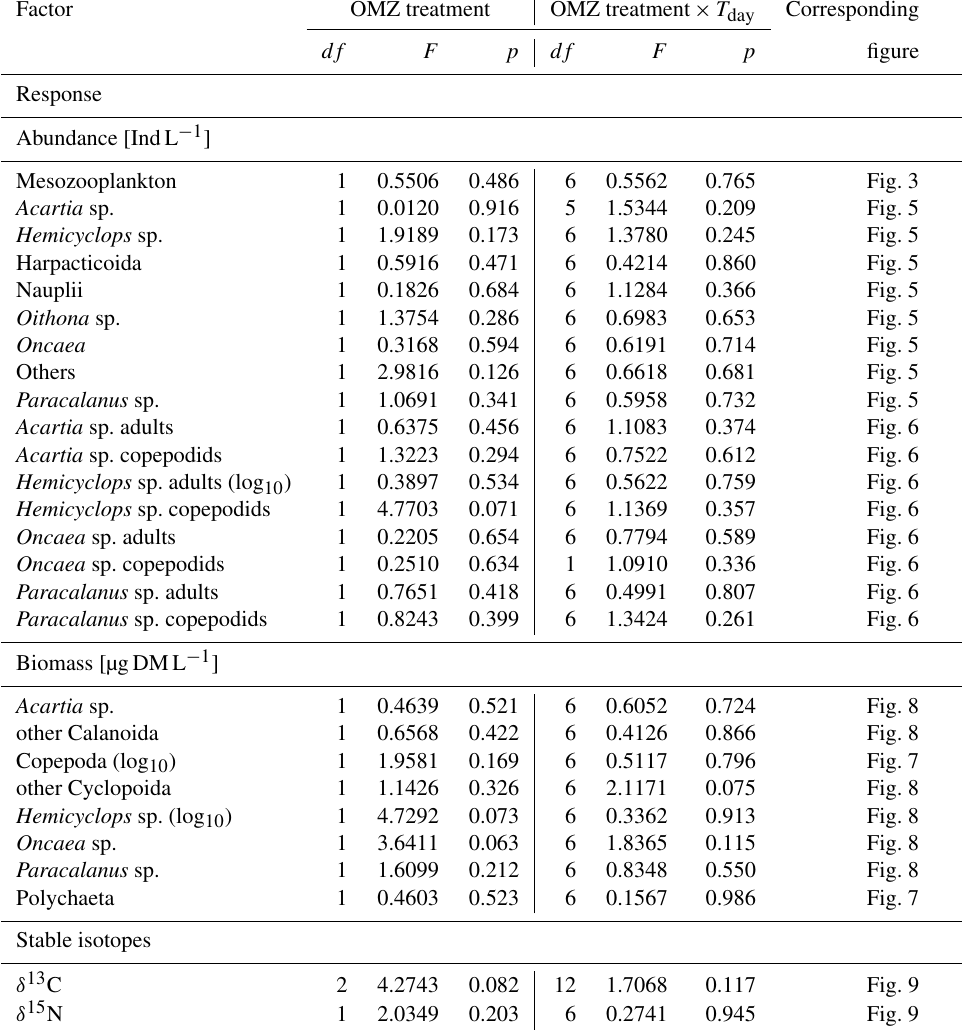
Table 1. Results of repeated measures ANOVAs. OMZ treatments (levels: moderate, extreme) and experiment day ( T day = day13–day48) served as independent variables (FACTOR). Abundance and biomass of zooplankton categories and stable isotope content of copepods served as dependent variables and are listed below as RESPONSE. Mesocosm was used as a random effect in the linear models. Response variables that were log 10 -transformed are indicated (log 10 ). Alpha level for p = 0 . 05. Note that single effects of the experiment day (time) are not listed as they are not of interest in the present study but were for most response variables significant ( p < 0 . 05). df : degrees of